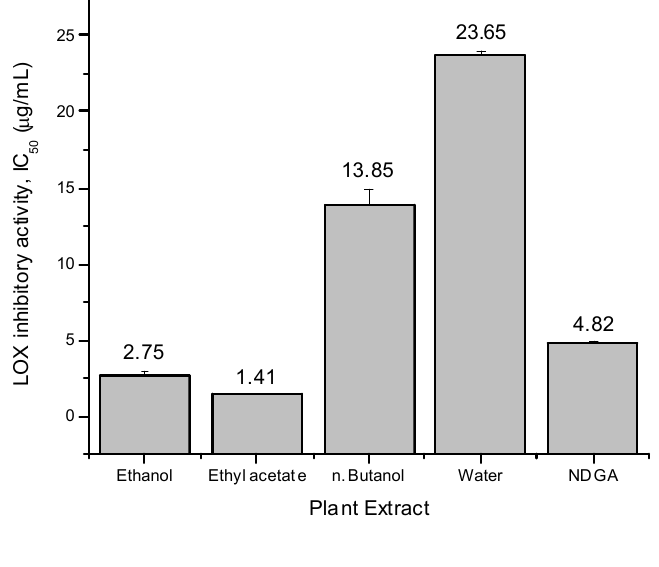
Figure 1. LOX inhibitory activities of ethanol extract and soluble fractions from Leptadenia pyrotechnica expressed as IC experiments.